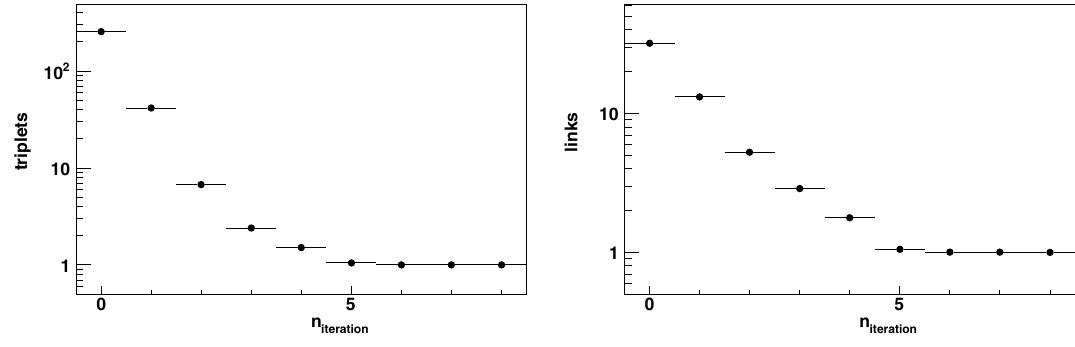
Figure 7. The exponential reduction in the number of hit triplets (left) and linked hit pairs (right) per node associated with a hit, at the end of each sort-cycle iteration (zero indicates the first